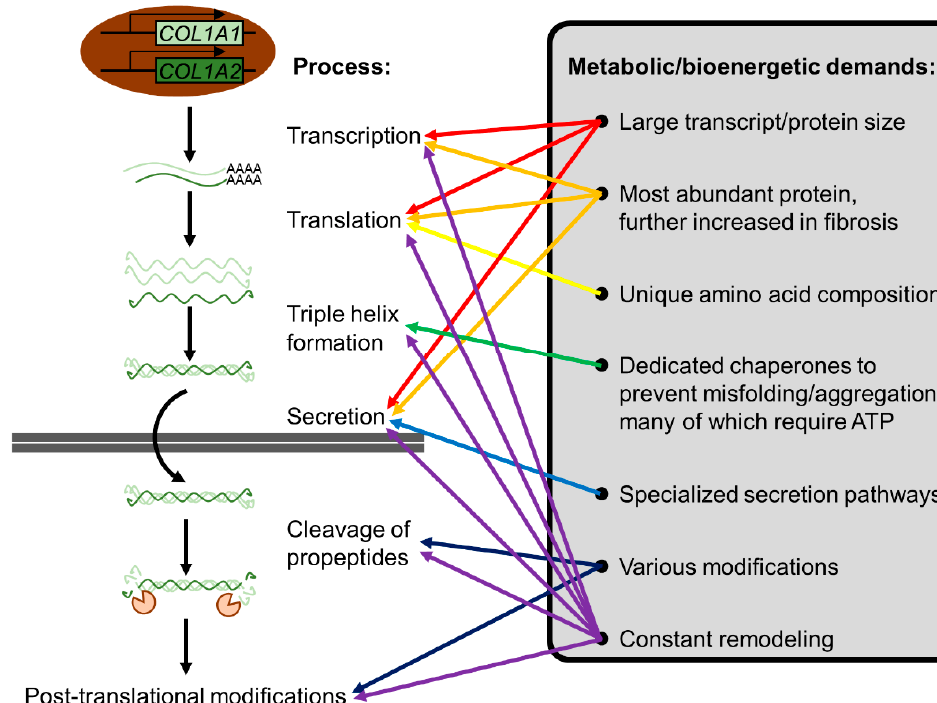
Figure 7. The metabolic/bioenergetic demands of ECM production. Using collagen I as an example, the metabolic/bioenergetic demands inherent to ECM production are illustrated. Its large size, abundance, unique amino acid composition, and tertiary structure pose a unique challenge for cells. Not only is transcription/translation metabolically costly, but chaperones to prevent misfolding/aggregation are also required. Moreover, collagens are secreted via specialized pathways due to their large size [204]. Various post-translation modifications and constant remodeling further increase metabolic/bioenergetic costs.